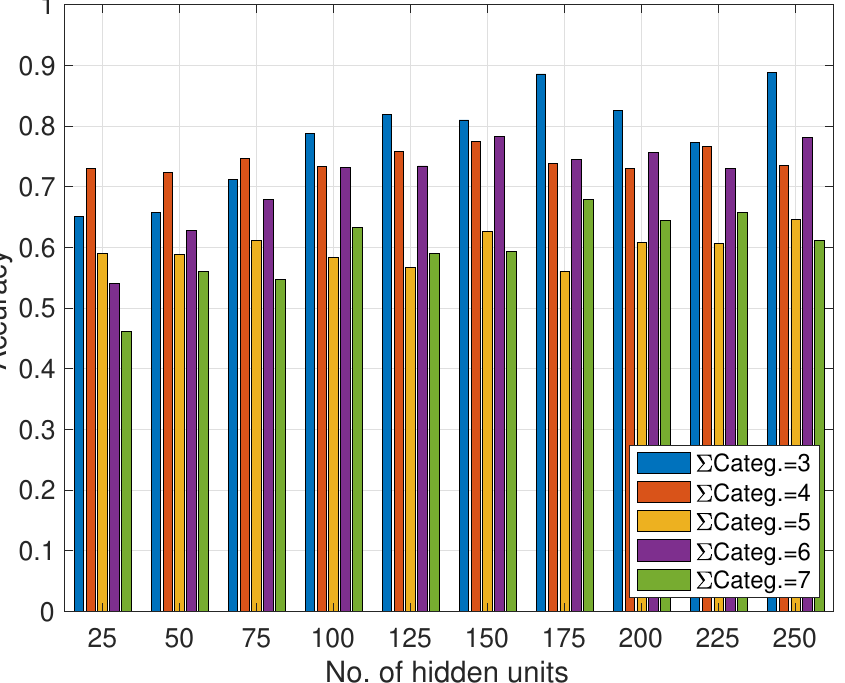
Figure 9. Classification accuracy versus number of hidden-units. Sensor = acceleration, solver = ADAM, sample-rate =